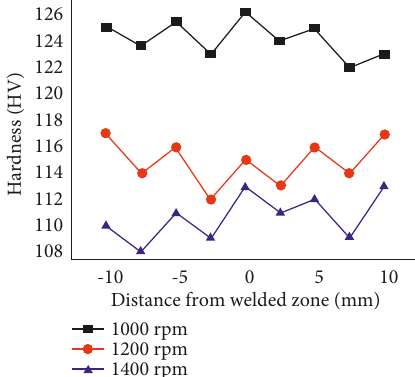
Figure 9: The hardness of the Cu-Br welded joint at various rotational speeds.